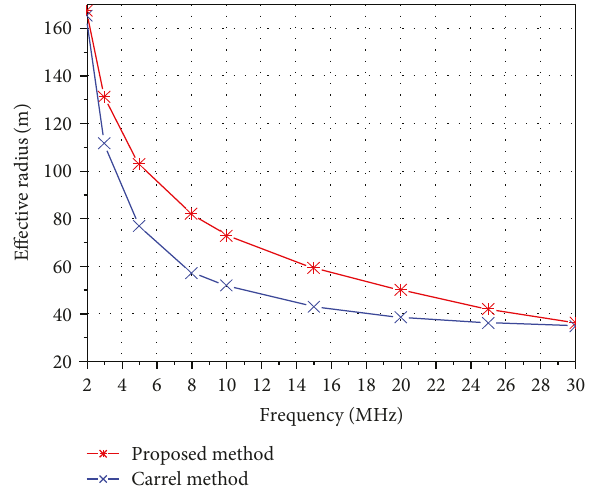
Figure 7: The e ff ective radius variation curve with